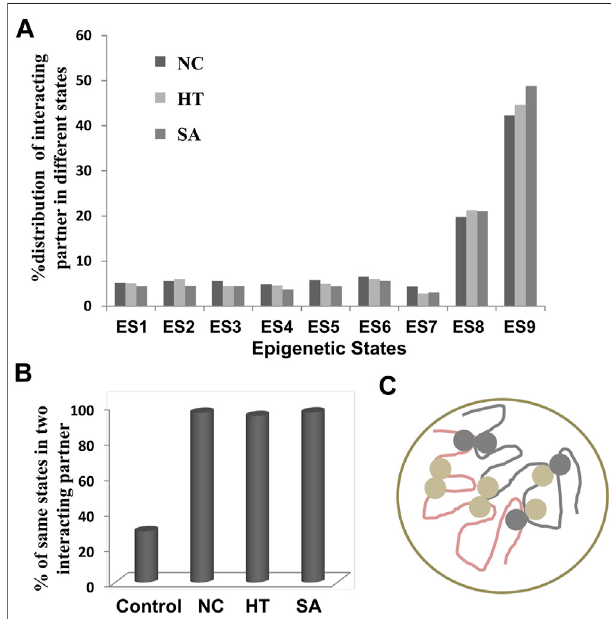
FIGURE 3 | Distribution of interacting regions into various epigenetic states. (A) Mapping of interacting regions on different epigenetic states as de fi ned previously (Sequeira-Mendes et al., 2014). Interacting regions were highly enriched in state 8 and 9 which are the marks for heterochromatic regions and the least represented in state 7 which is exclusively associated with the intragenic regions. (B) The interactions frequency of two interacting regions among the NC, HT, and SA libraries sharing the same ES is signi fi cantly high over the control sets of interacting regions ( p -value < 0.00001) indicating that interactions were fi rmly associated with the epigenetic states of interacting regions. (C) Cartoon representing the interactions among the same ES is more frequent than the different ES (light and dark grey circles represent the different